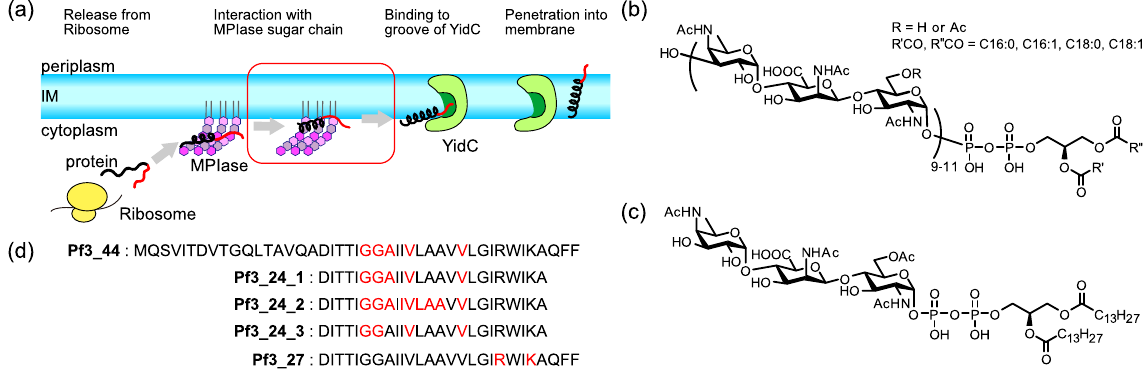
Figure 1. ( a ) Schematic of the pathways involving post-translational Sec-independent protein insertion into the inner membrane (IM) of the E. coli . Small membrane protein is released from a ribosome and binds to the sugar chains of membrane protein integrase (MPIase). MPIase prevents the protein from aggregating and alters the secondary structure of the protein. The hydrophobic region of protein proceeds into the membrane. Subsequently, the hydrophilic region binds to the hydrophilic groove (dark green) of an insertase, YidC (green) and is further translocated across the periplasmic membrane leaflet. In this study, we focused on the process outlined in red in the figure. ( b ) Molecular structure of MPIase. Approximately one-third of the 6-position on GlcNAc residues is O -acetylated. The number of repeating trisaccharide units ranges from 7 to 14, but most are from 9 to 11. ( c ) Mini-MPIase-3, which is a synthetic analog. ( d ) Amino acid sequence and variation of the selective 15 N label of substrate protein used in this study: full-length Pf3 coat protein Pf3_44, and its substructures, Pf3_24_1, Pf3_24_2, Pf3_24_3, and Pf3_27. 15 N-labeled amino acids are colored in